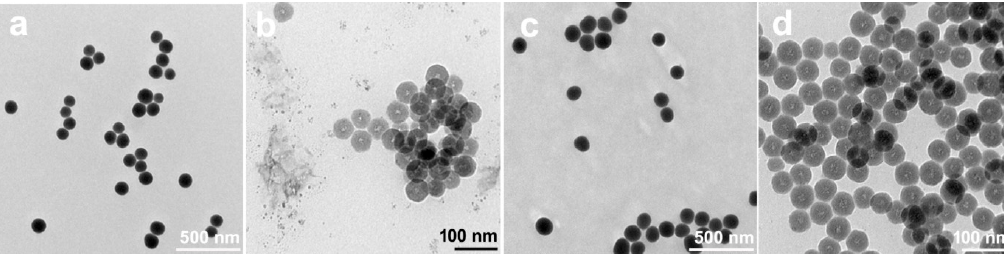
Figure 1. TEM-images of Co II @SiO 2 nanoparticles obtained by: Stober procedure ( a , c ) and water-in-oil microemulsion technique ( b , d ) on the basis of Co II (bpy) 3 ( a , b ) and CoCl 2 ( c , d ) as dopants. Table 2. Average diameters (d) in dried samples (TEM), Si:Co molar ratio (ICP-OES), average hydrodynamic diameters (D), polydispersity index (PDI) and zeta potential values ( ζ ) (DLS) in aqueous colloids of the differently synthesized Co II @SiO 2 (C = 0.2×g·L − 1 ) .